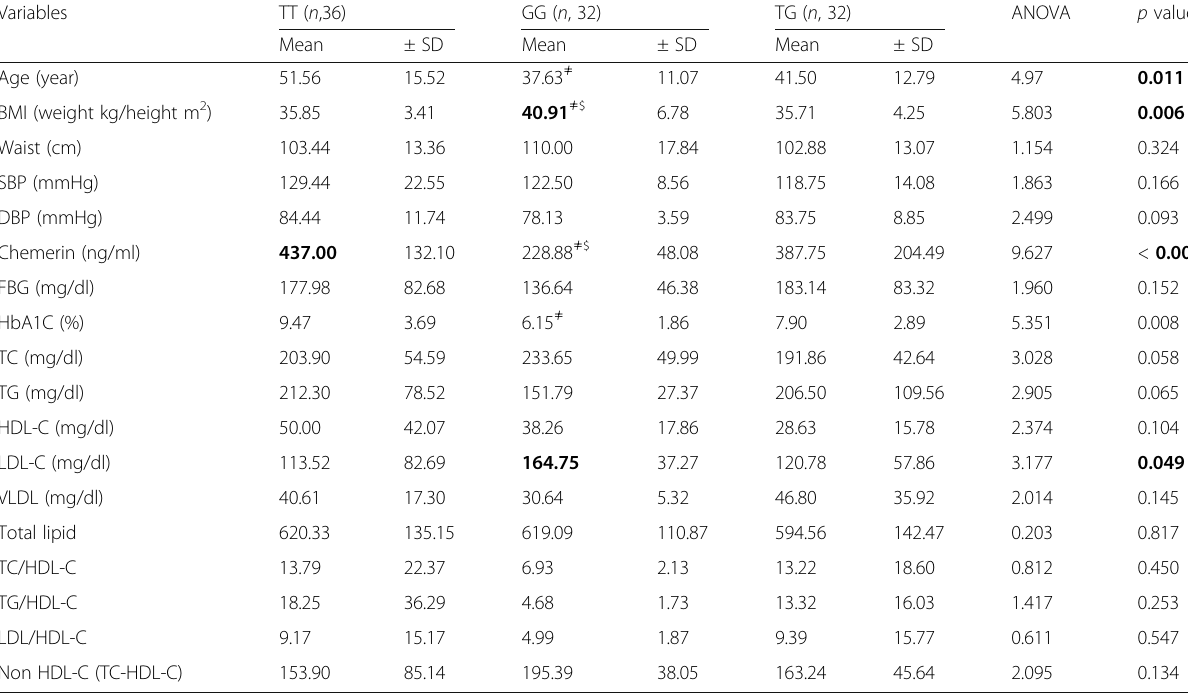
Table 5 Comparison between genotypes of RARRES2 rs17173608 gene polymorphism according to demographic characters, criteria of MetS, and chemerin level in the MetS group ( n = 100)